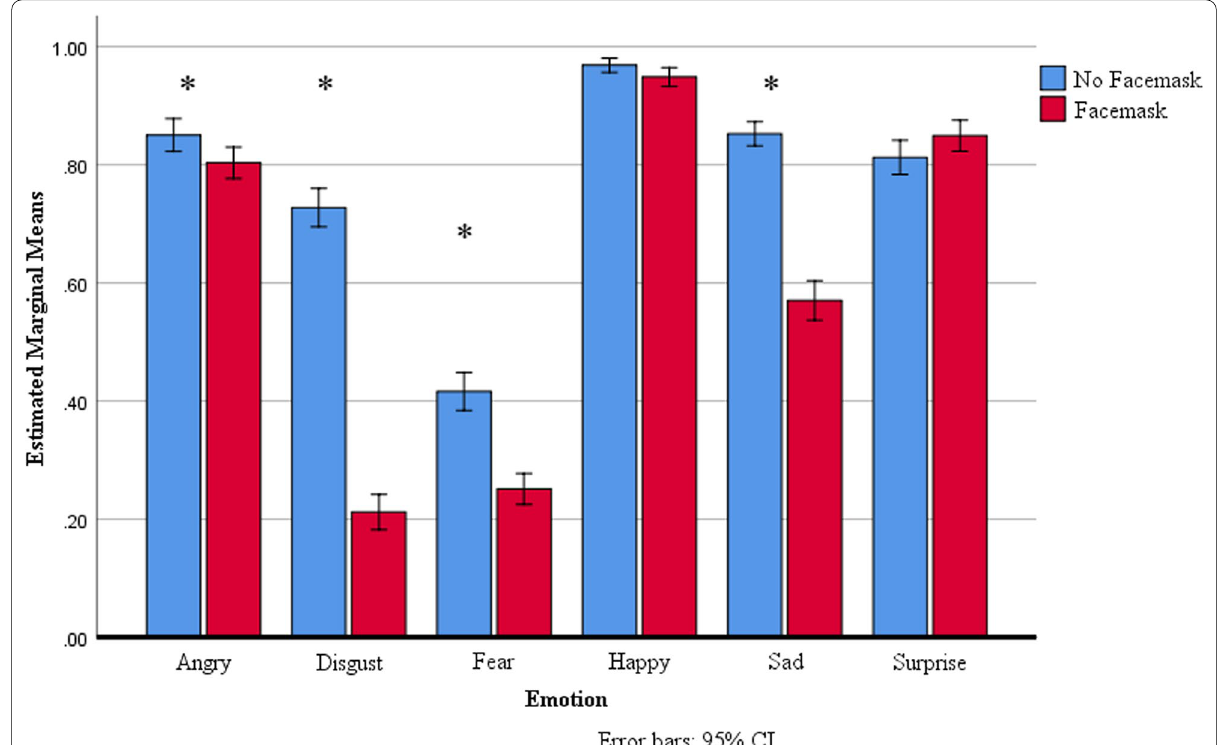
Fig. 2 Mean accuracy of response for Emotion in face mask and no face mask conditions. Mean percentage of correct assessment of the emotional states for faces with masks (red) and faces with no mask (blue). Error bars indicate 95% confidence intervals. Asterisks indicate statistical difference with Bonferroni-corrected alpha level ( α <